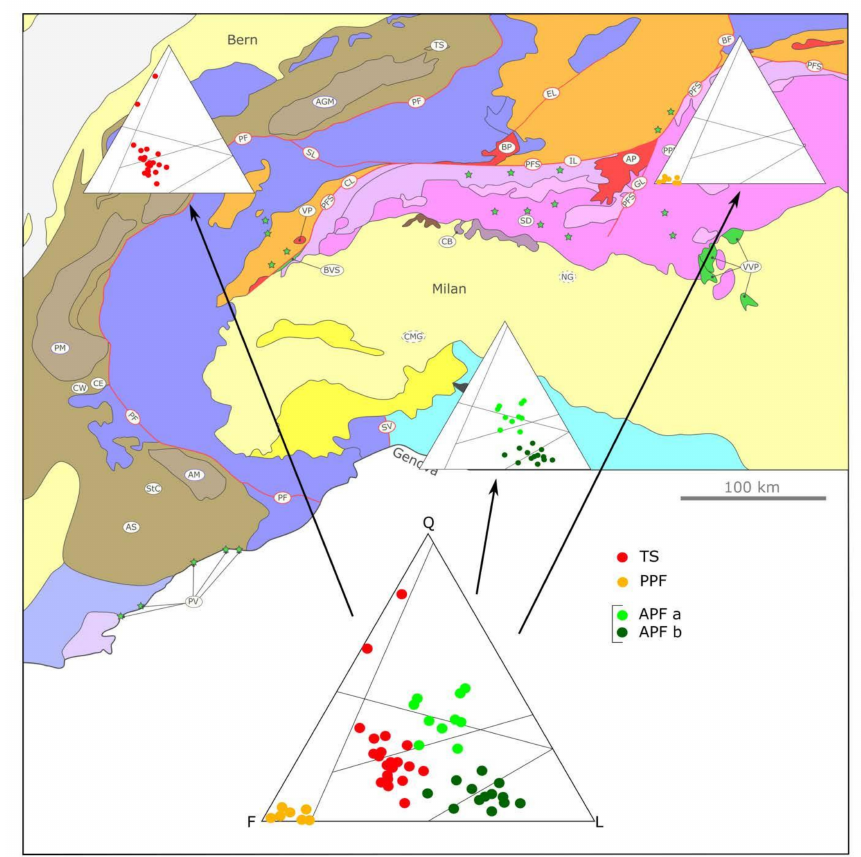
Figure 3. QFL tot diagrams. TS = Taveyanne Sandstones [31]; PPF = Ponte Pi à Formation [32]; APF = Val d’Aveto-Petrignacola Formation nonvolcanic deposits ( a ) and volcanogenic deposits ( b )